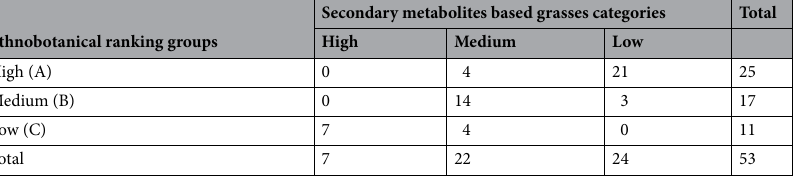
Table 3. Crosstab analyses between secondary metabolites based grass categories and ethnobotanical ranking groups of studied ethnobotanical fodder grasses.